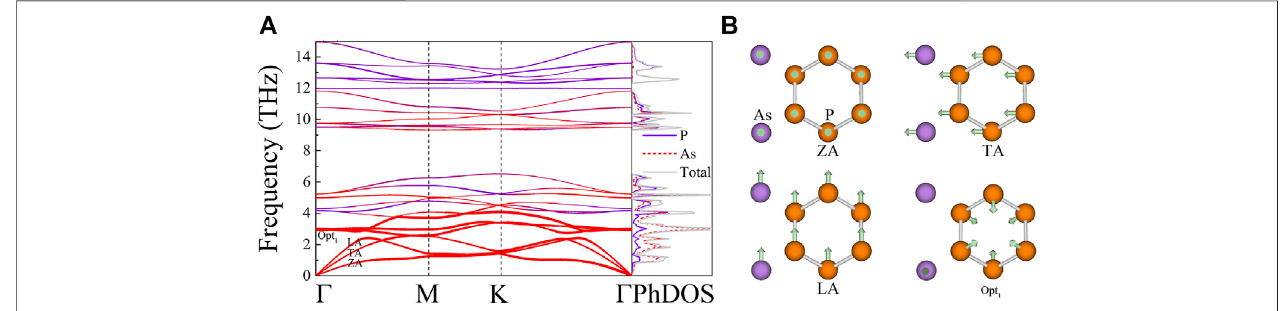
FIGURE 4 | (A) Phonon spectra and phonon density of states (PhDOS) for AsP 3 , (B) the corresponding vibrational modes of the acoustic phonon branches (ZA, TA, and LA), and the lowest optical branch (Opt 1 ) near and at the Γ point.